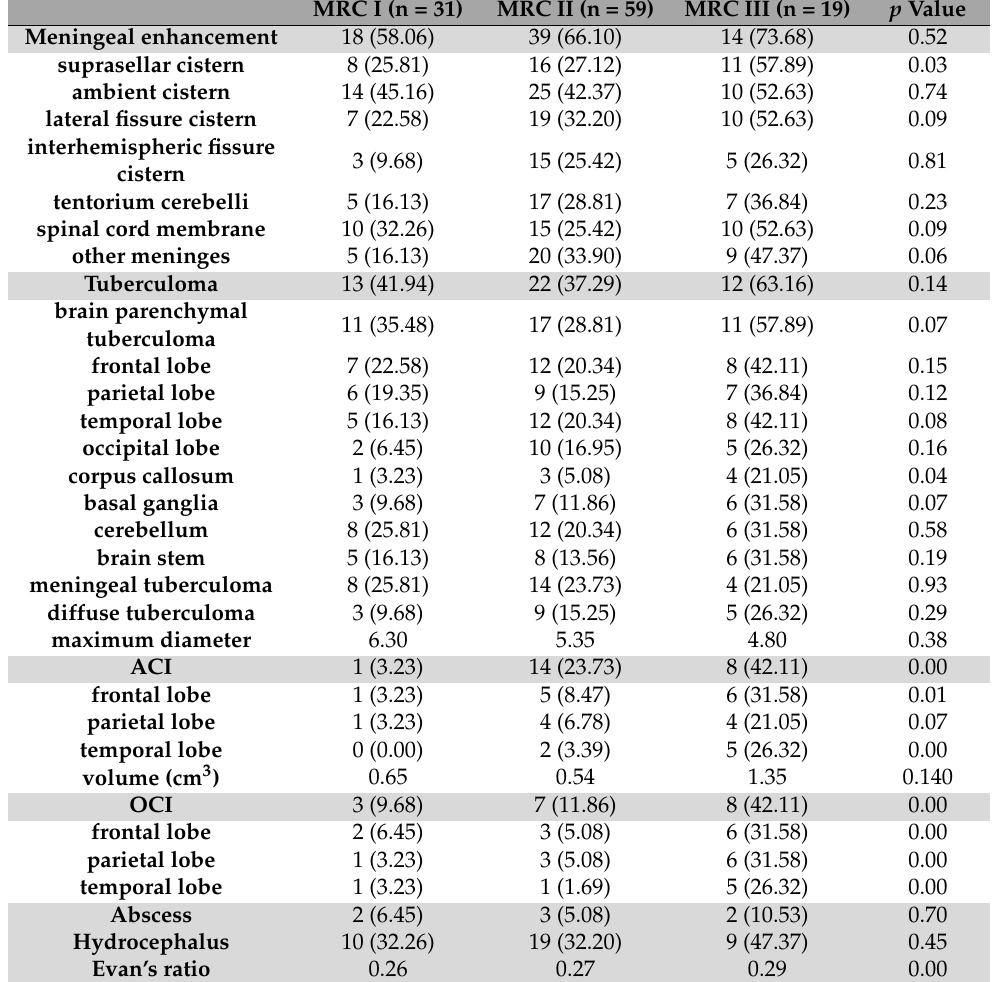
Table 3. MRI features of TBM patients with different degrees of neurological